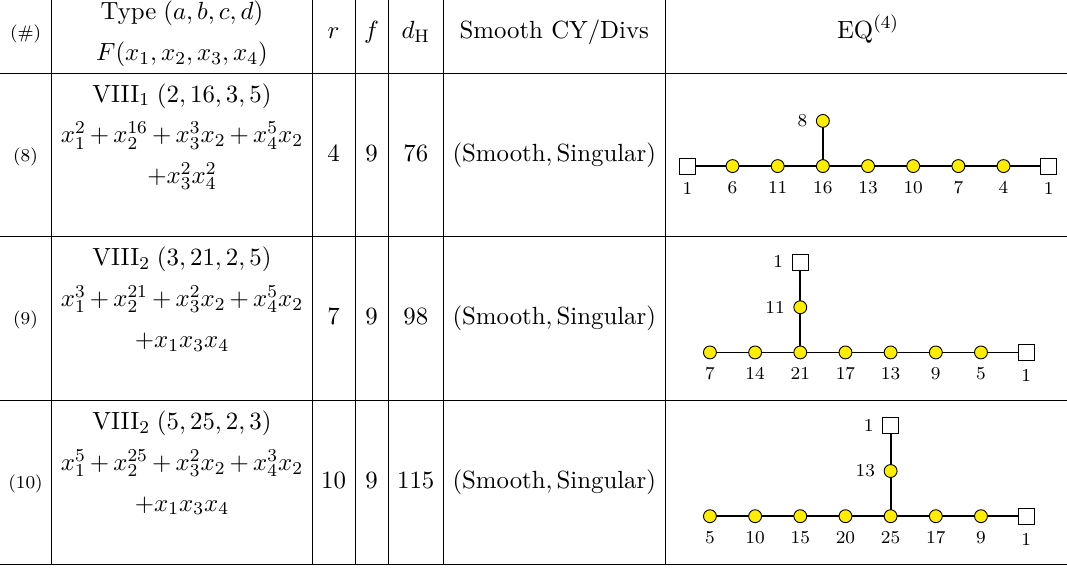
Table 13 . Basic data and EQ (4) for the ‘sporadic’ SU( N ) trinions, continued